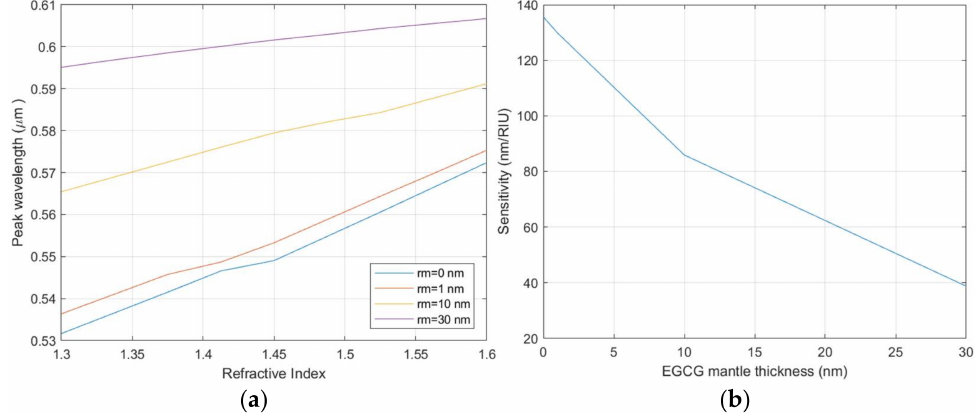
Figure 11. ( a ) Variation of the central wavelength for the LSPR resonance as a function of the medium refractive index for different thickness of the EGCG capping layer. ( b ) Sensitivity of the NPs’ LSPR as a function of the EGCG capping layer thickness.